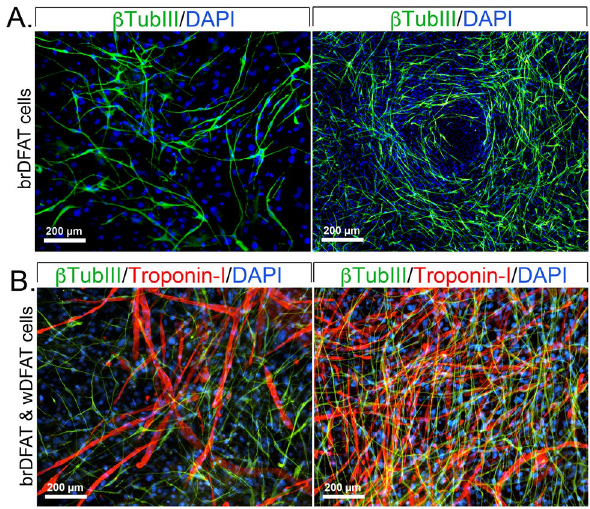
Figure 5. Potential use of mouse DFAT cells as a progenitor cell model. ( A ) Expression of βTubIII (green) in brDFAT cells after 10 days (left) and 15 days (right) in neural induction medium. ( B ) Immunolocalization of Troponin-I (red) and βTubIII (green) in cultures of combined wDFAT and brDFAT cells, which showed both cardiomyogenic and neurogenic differentiation after 10 days (left) and 15 days (right) in neural induction medium. DAPI (blue) was used to visualize